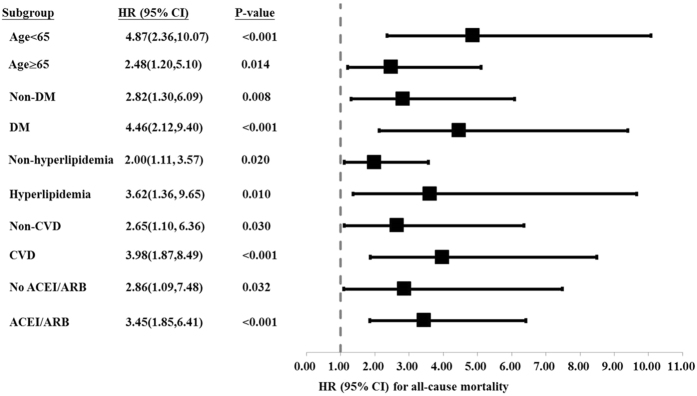
Subgroup analysis showing adjusted hazard ratios for all-cause mortality in the high RDW group compared with the low RDW group.